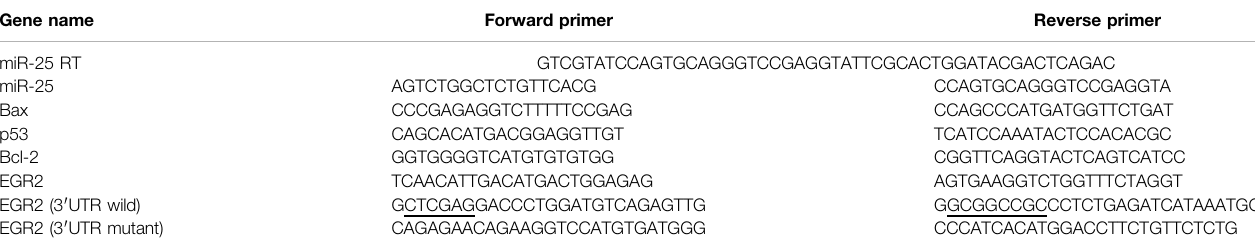
TABLE 1 | The gene primer sequence for RT-qPCR or